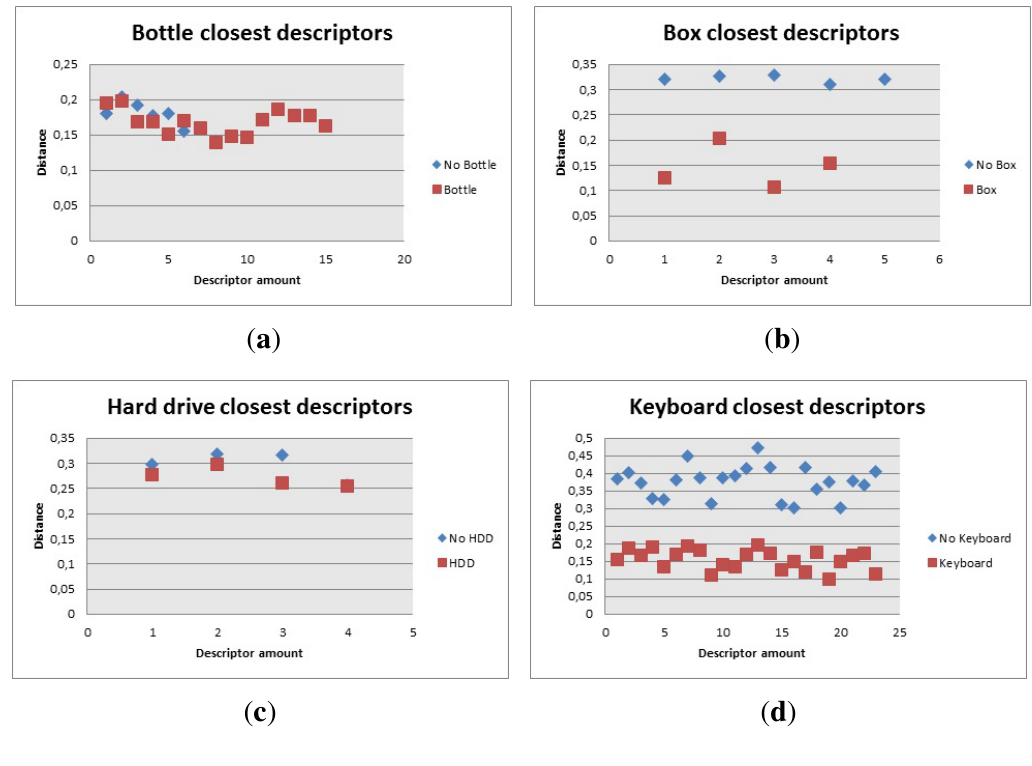
Figure 23. Closest descriptors with and without object. ( a ) Closest descriptors with and without bottle; ( b ) Closest descriptors with and without box; ( c ) Closest descriptors with and without hard drive; and ( d ) Closest descriptors with and without keyboard.